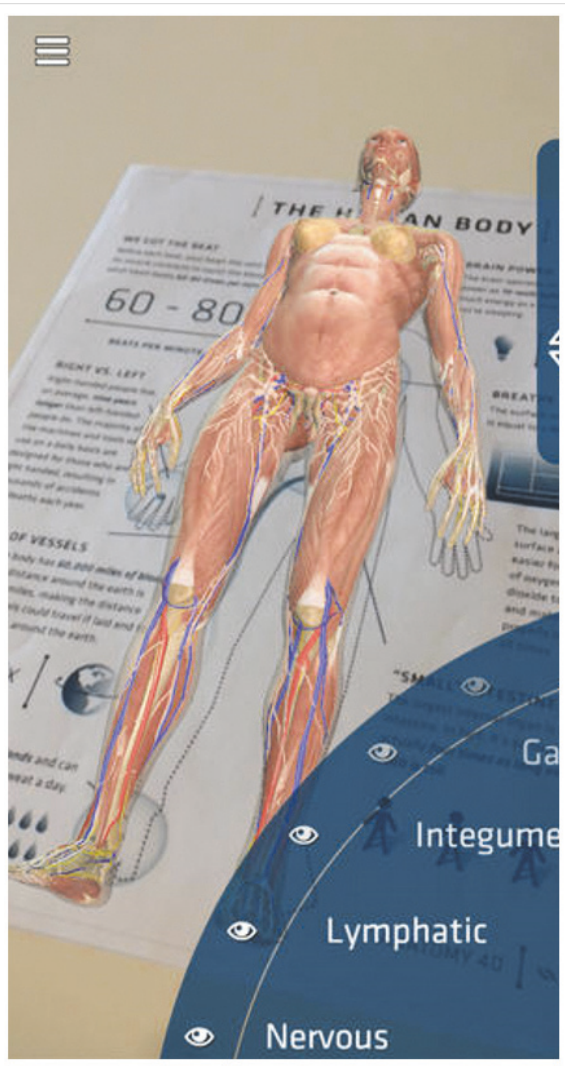
Figure 4: Anatomy 4D mobile application screenshot